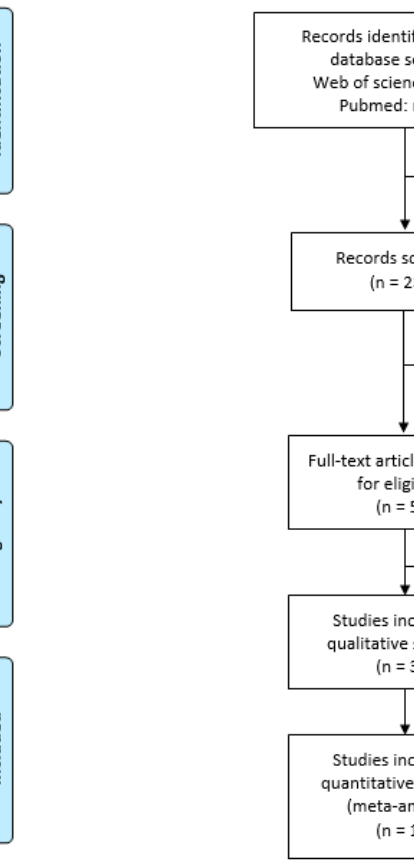
Figure 1. Flow diagram of chosen studies for the present metanalysis.